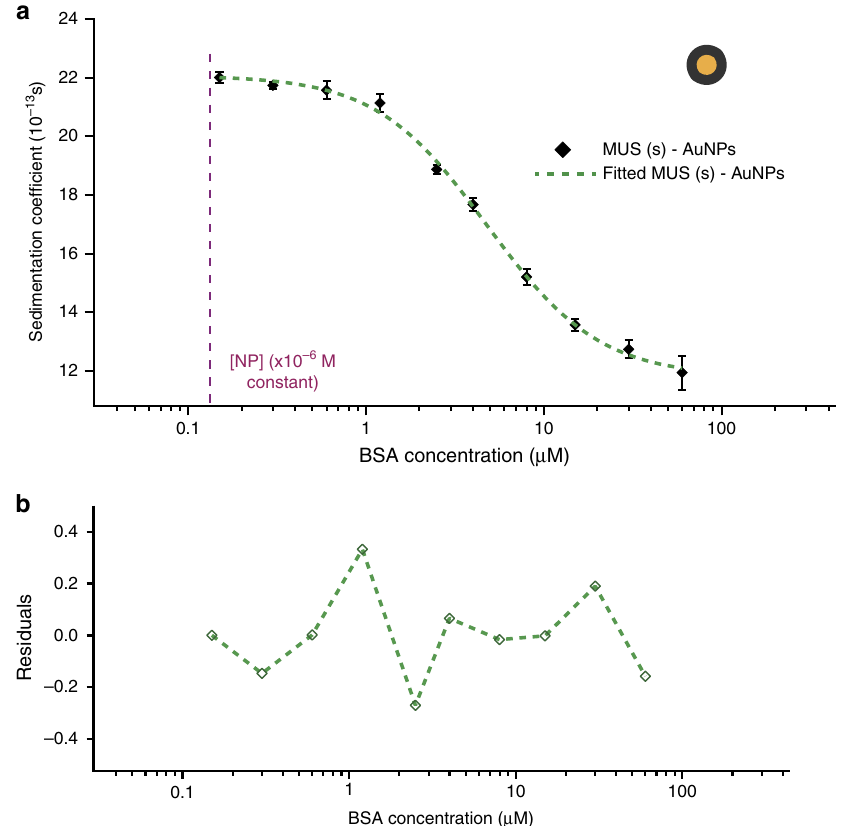
Figure 3 | SV-AUC binding isotherm for very small AuNPs. ( a ) Plot of average s versus BSA concentration for MUS(s)–AuNPs ( d H ¼ 5.6nm). Error bars represent the standard deviation of three independent measurements from the same batch of NPs. ( b ) Residuals plot of the fit function of MUS(s)–AuNPs– BSA isotherm. Dashed magenta line indicates the nanoparticle concentration kept constant during